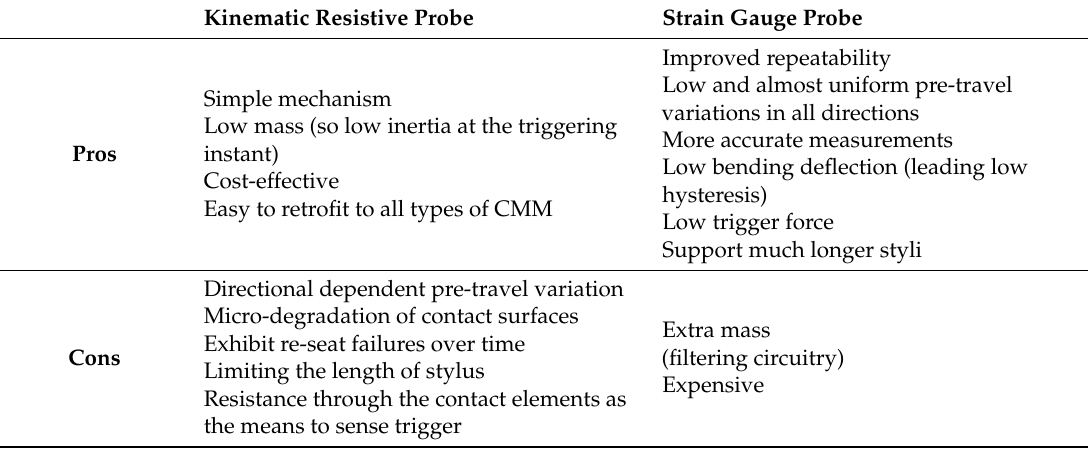
Table 1. Comparison table between kinematic and strain gauge probing technology